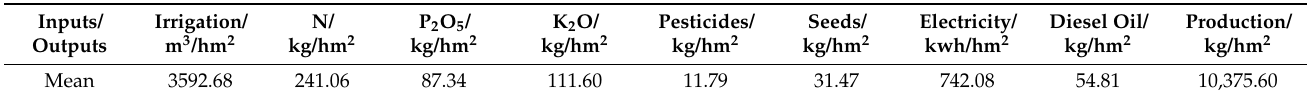
Table 2. Material input and production of rice in the sample